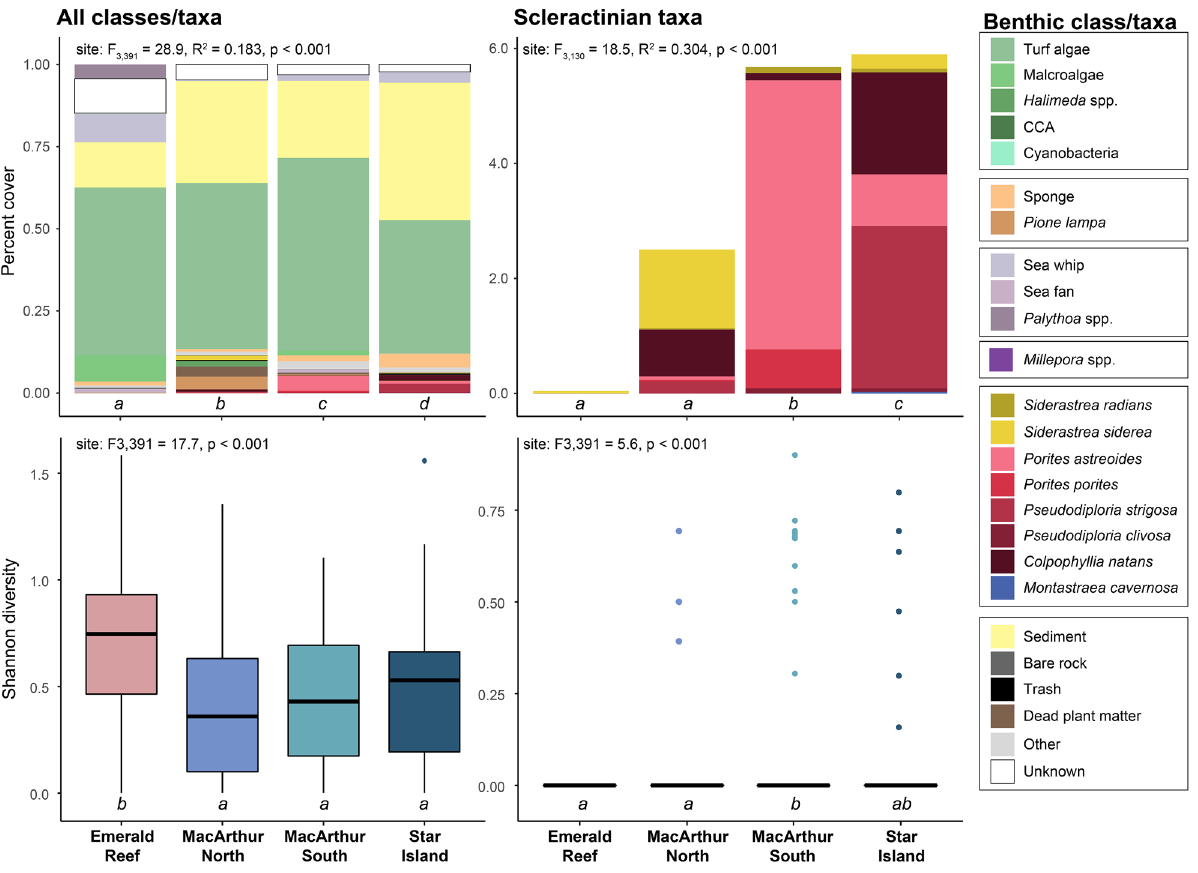
Figure 5. Benthic community composition and Shannon diversity metrics across offshore and urban sites (left column), with subset datasets for scleractinian taxa only (right column). Percent cover statistics represent results of PERMANOVAs, and diversity statistics represent ANOVA results. Groups which share a letter are not significantly